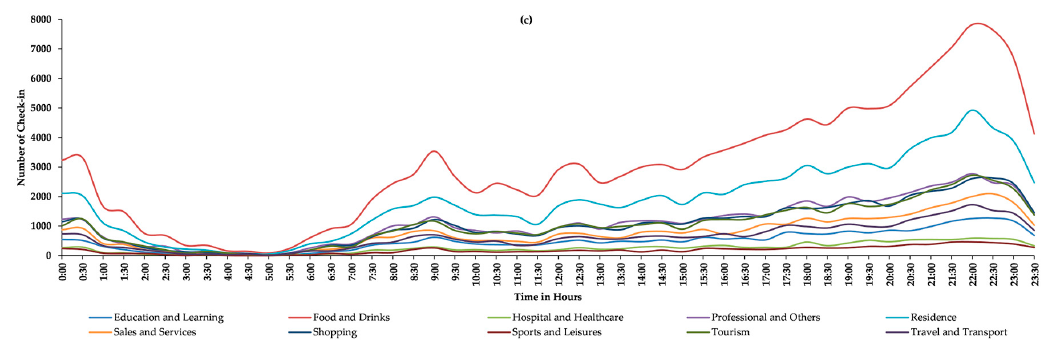
Figure 10. Temporal trend of activities in Shanghai: ( a ) overall, ( b ) men, ( c ) and women.